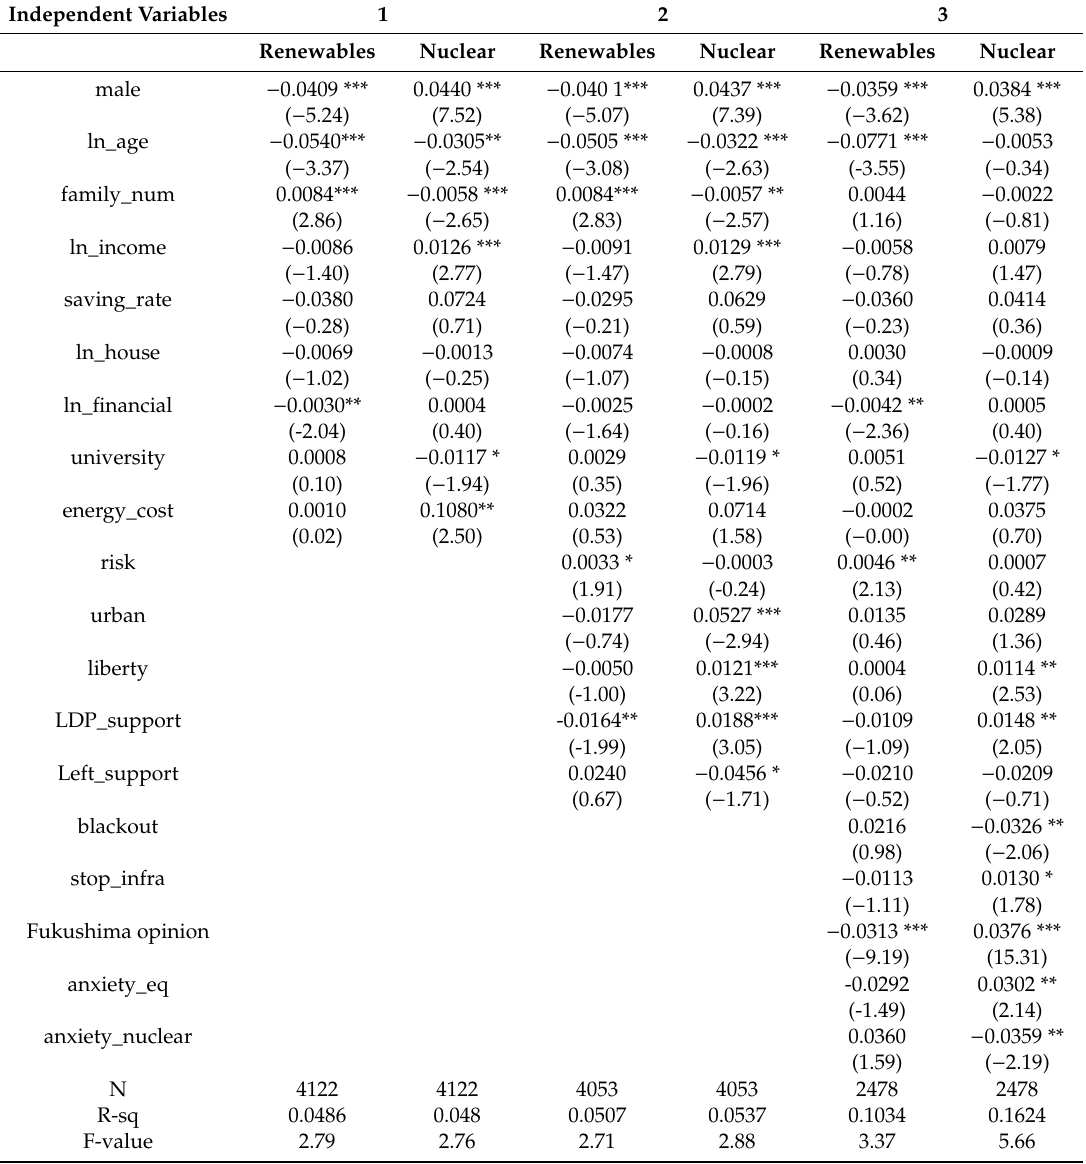
Table 2. Estimation result